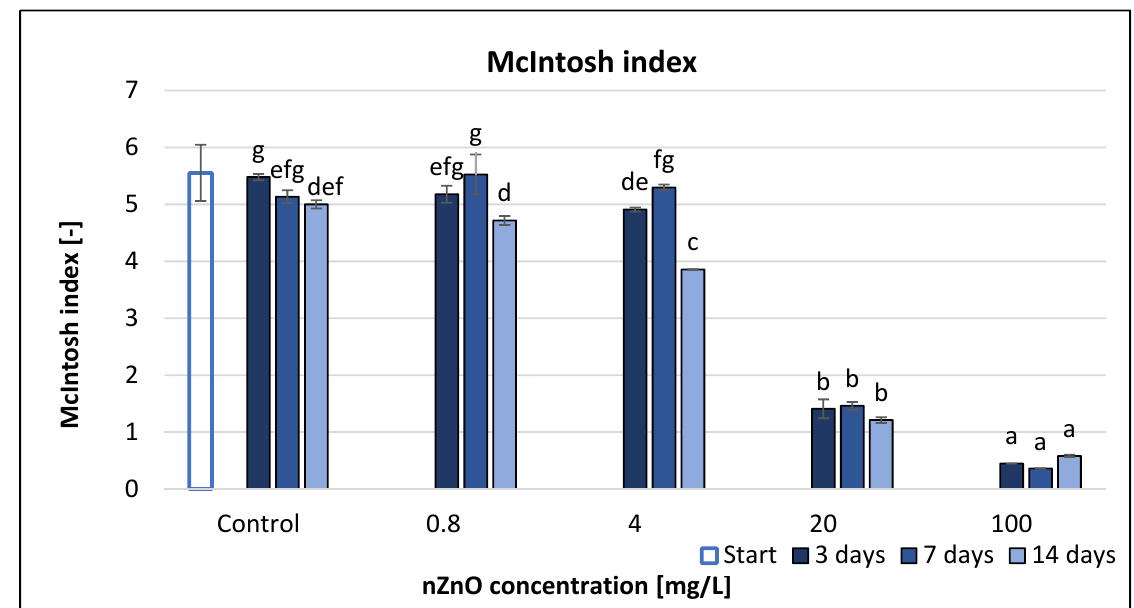
Figure 7. The effect of ZnO nanoparticles on freshwater McIntosh index value. Letters on the columns indicate significant differences (level of significance: p < 0.05).